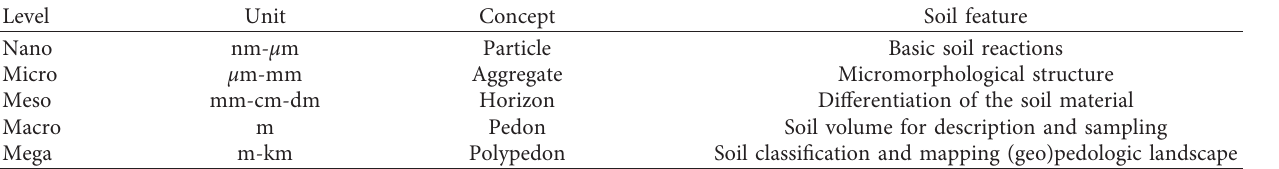
Table 1: Hierarchic levels of the soil system